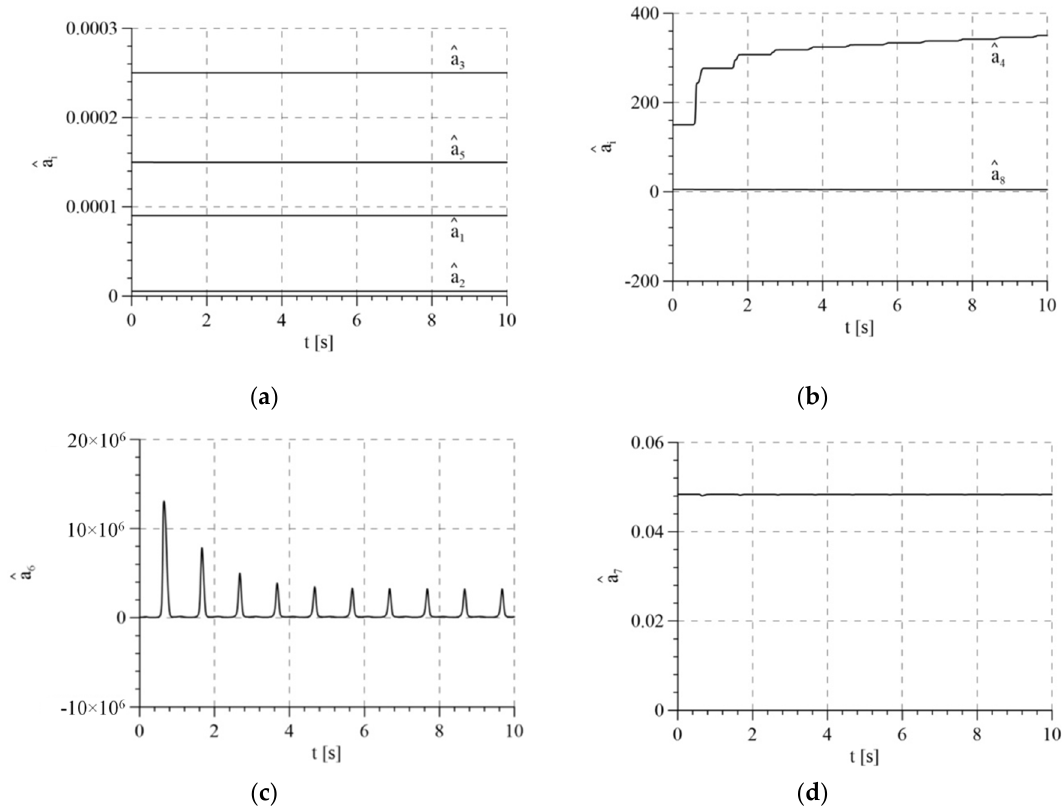
Figure 10. Estimates of model parameters for variant 3: ( a ) estimates of parameters ˆ a 1 , ˆ a 2 , ˆ a 3 and ˆ a 5 ; ( b ) estimates of parameters ˆ a 4 and ˆ a 8 ; ( c ) estimate of parameter ˆ a 6 ; ( d ) estimate of parameter ˆ a 7